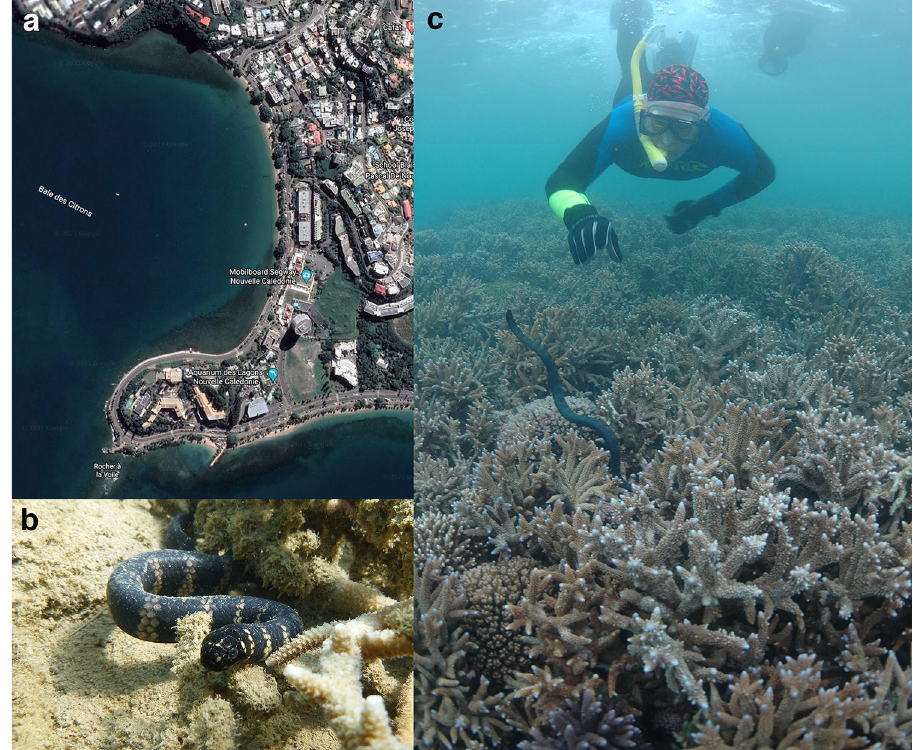
Figure 3. Photographs of ( a ) the study areas in which we conducted mark-recapture studies on sea snakes; ( b ) a turtle-headed sea snake, Emydocephalus annulatus ; ( c ) capturing a snake during annual surveys. Photographs by Google Earth ( a ), Claire Goiran ( b ), and Pierre Larue ( c ). Map data: Google Earth